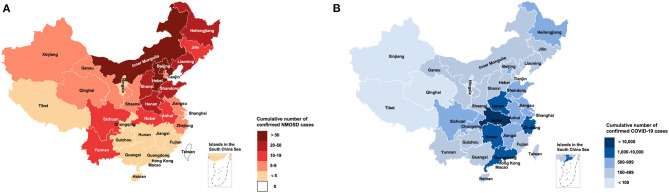
Distribution map of NMOSD cases (A) and COVID-19 cases (B) across China.